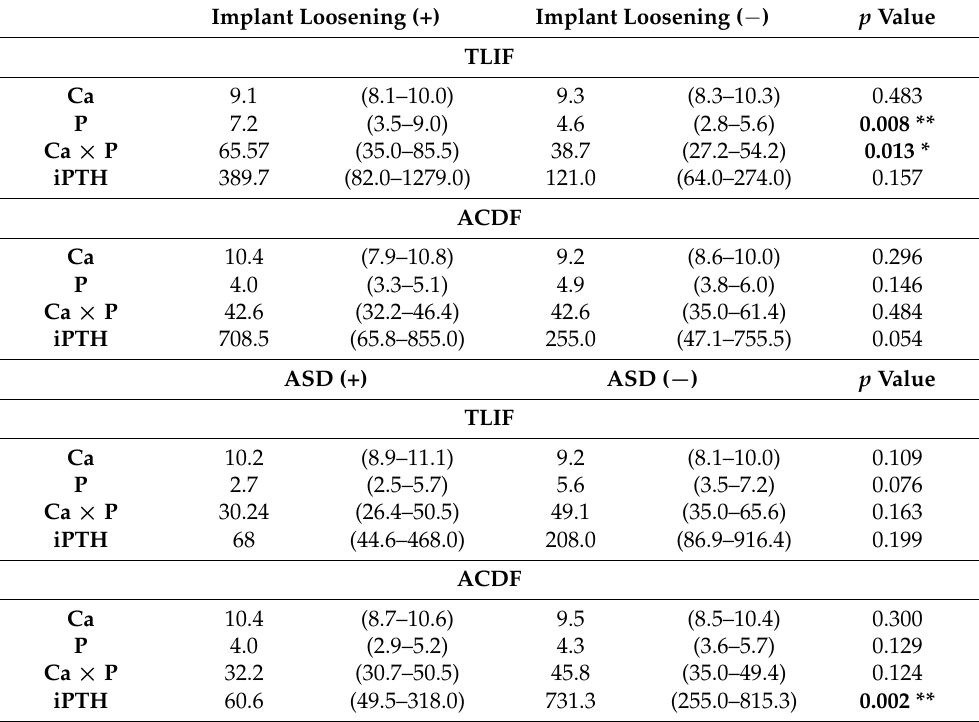
Table 4. Correlation between the incidence of implants loosening/ASD and serum level of Ca, P, Ca × P, and iPTH in the TLIF and ACDF